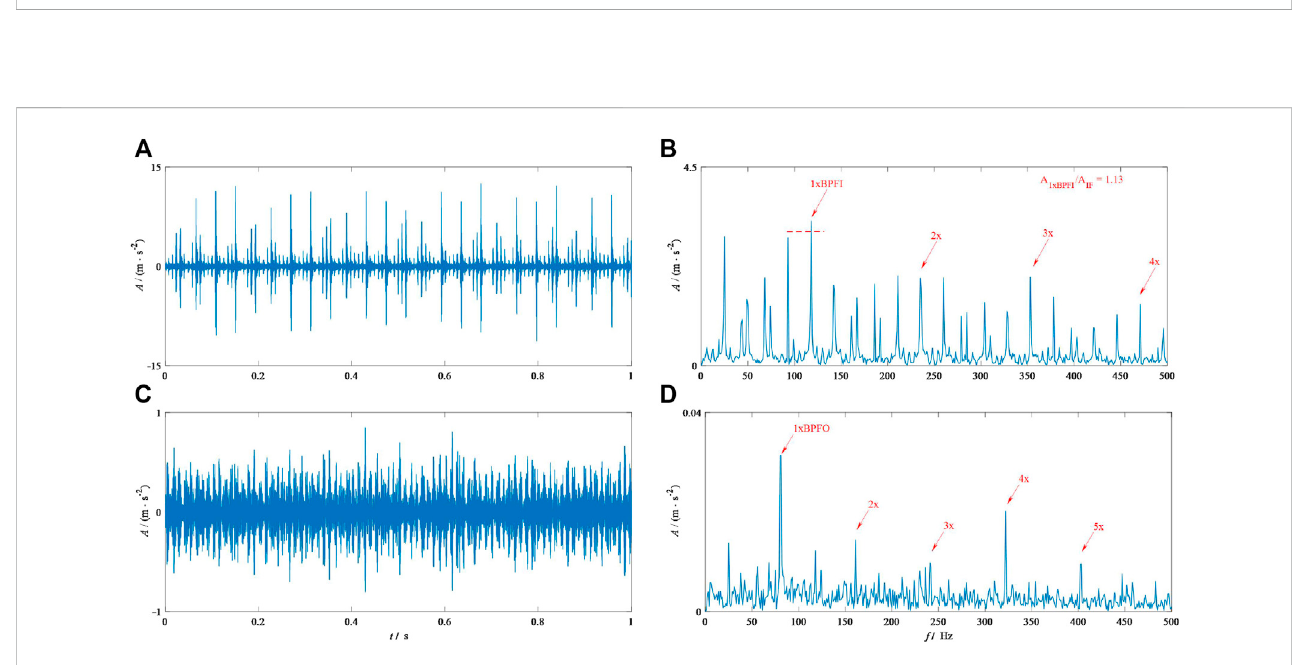
FIGURE 10 Results from IEFI – VMD for the MFPT signals: (A) and (B) correspond to the TDW and the corresponding SES of the inner race fault bearing; (C) and (D) correspond to the TDW and the corresponding SES of the outer race fault